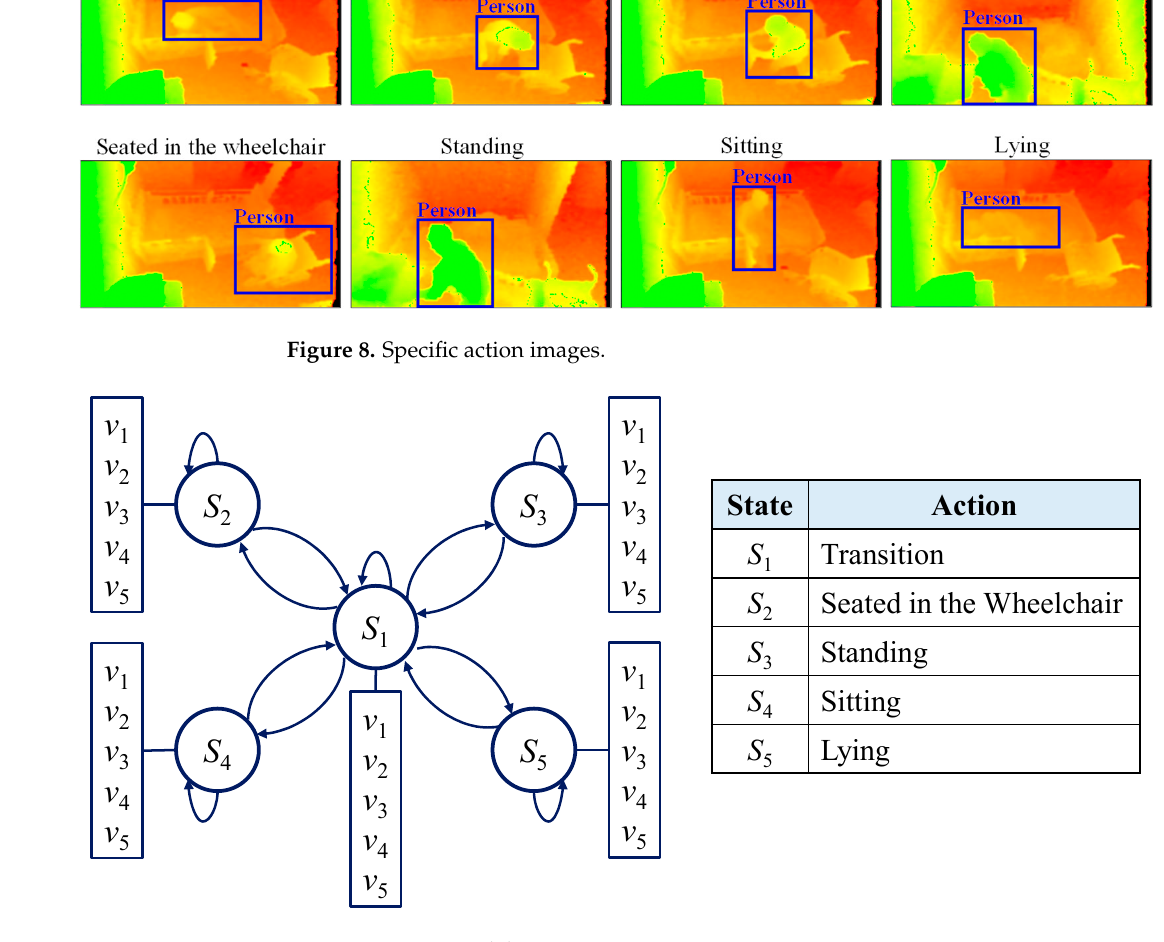
Figure 9. HMM model structure.